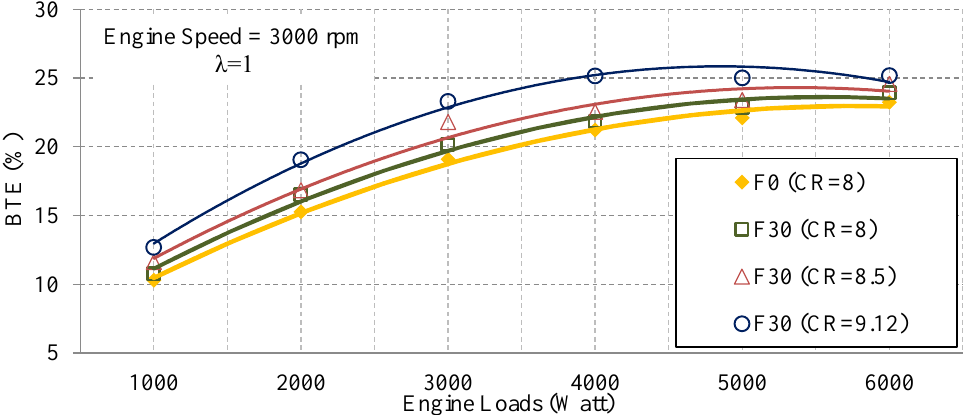
Figure 7. Overall efficiency graph for F0 and the F30 blend at different compression ratios.